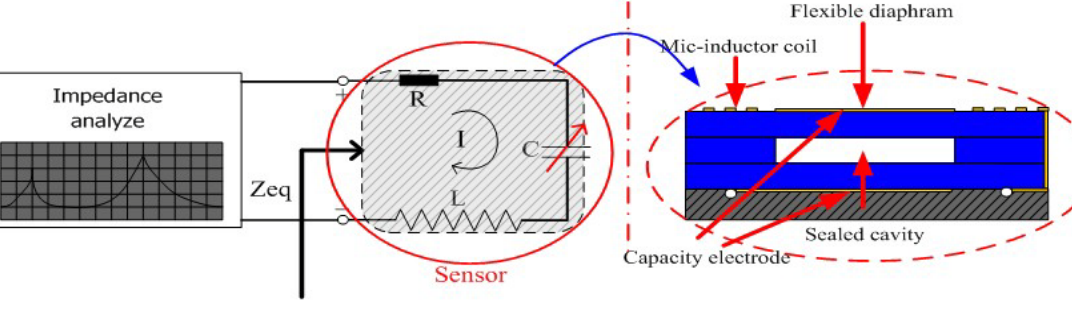
Figure 1. ( Left ) Pressure testing schematic; ( Right ) Design schematics of the